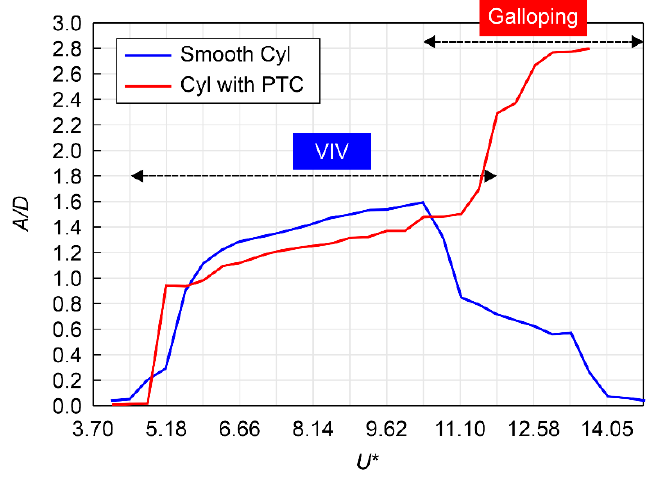
Figure 4. Flow induced motions (FIM) zone nomenclature for a circular cylinder with PTC [1].